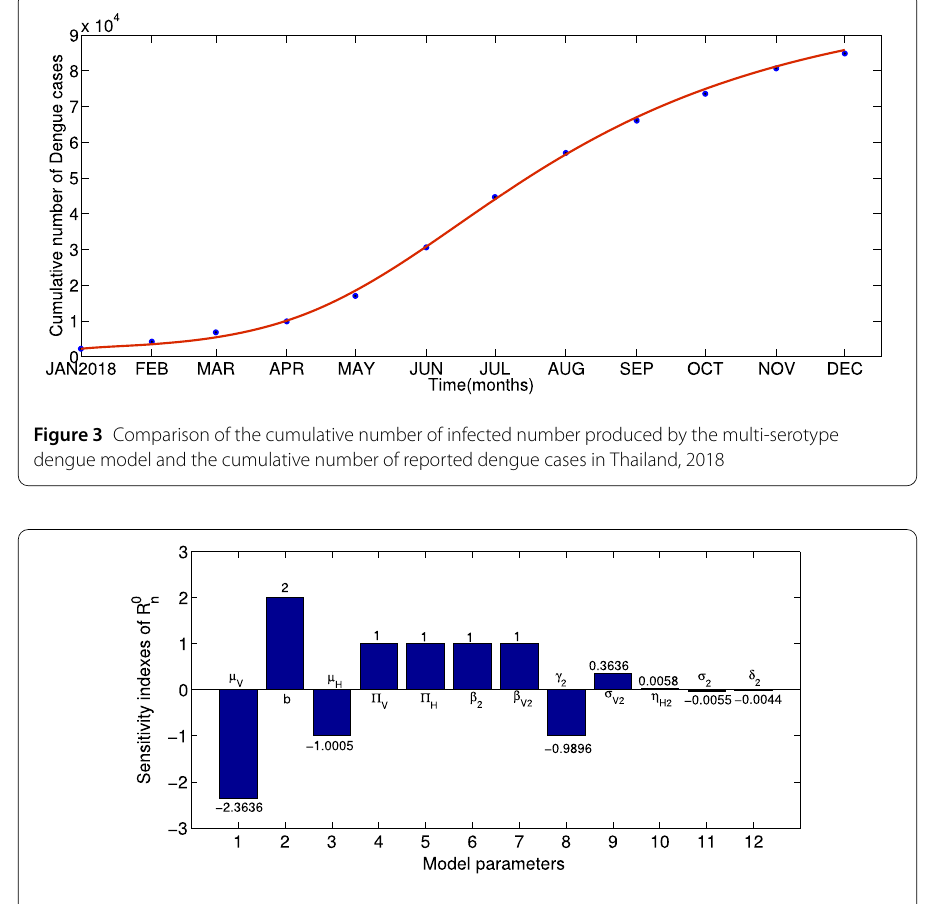
Figure 4 Sensitivity indexes of R n 0 = R n n 2 to the twelve different parameters for dengue serotype-2: μ V , b , μ H , Π V , Π H , β 2 , β V 2 , γ 2 , σ V 2 , η H 2 , σ 2 , δ 2 at the baseline parameter values given in Table